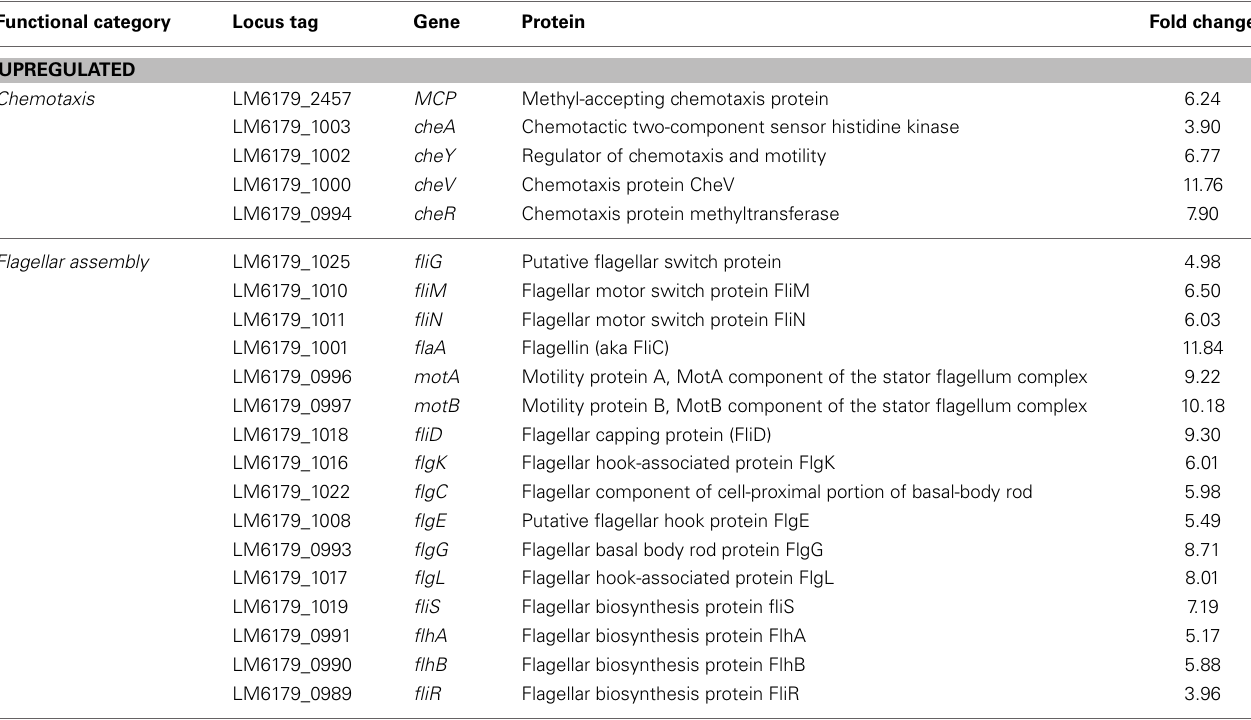
Table 2 | Chemotaxis and flagellar assembly genes which change in regulation following exposure of strain 6179 to BZT. Functional category